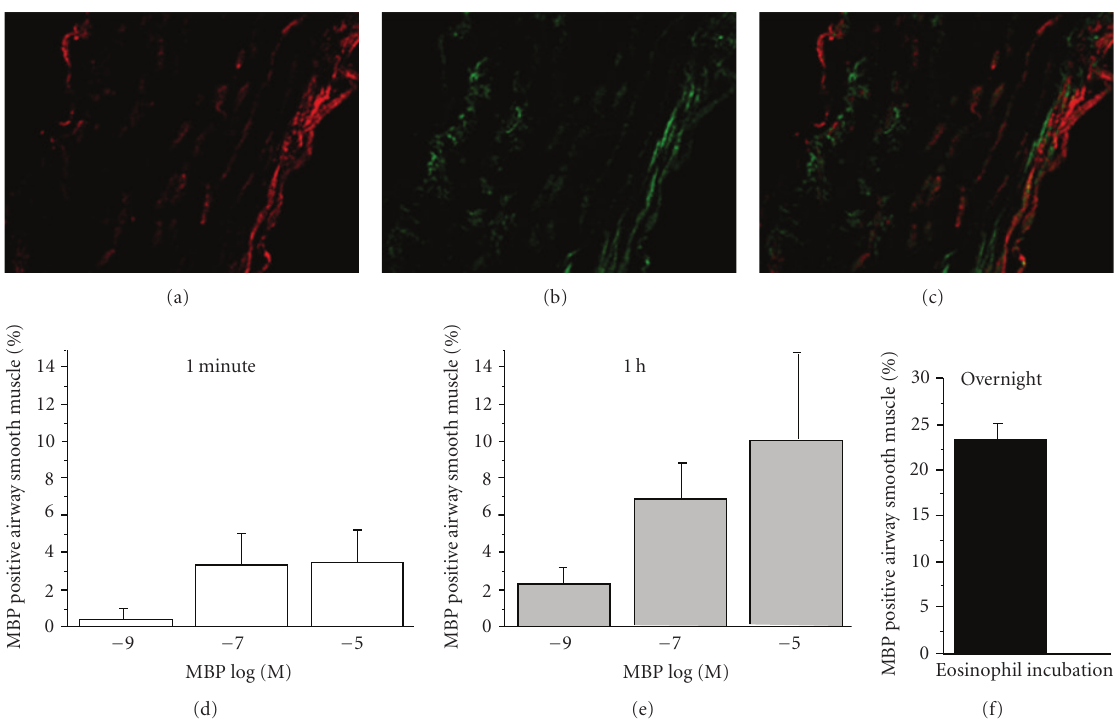
Figure 8: Immunolocalization of MBP in human airway following exogenous application of MBP or following incubation with eosinophils. Separate images showing smooth actin and MBP were examined. (a) shows MBP distribution (red), (b) image shows smooth muscle actin (green), and (c) image shows putting the two images together in binarized colabed images. Using the Metamorph system, the two pictures were analyzed to find areas measured in pixels. Exposure of 1min (solid) or 1h (light gray) as to higher concentrations of MBP allowed more MBP to access smooth muscle area compared to lower concentrations no significance was found by percentage smooth muscle with MBP in smooth muscle area. For same concentrations, longer exposure, 1h compared to shorter exposure, 1min, increased the percentage of smooth muscle colocalized with MBP. Additionally, substantial MBP (23.8% ± 4.9) was found in the ASM layer following overnight